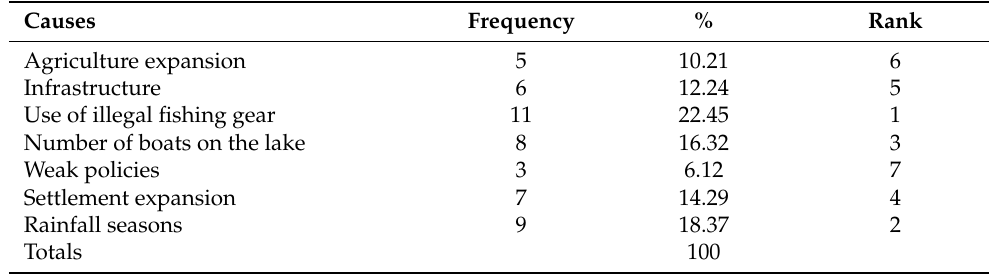
Table 8. Causes of LULC changes on Lake Kyoga and its immediate